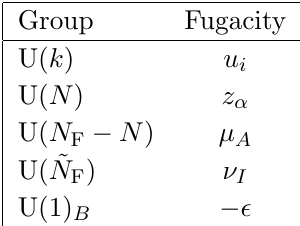
= 1, U( N ) gauge theory N